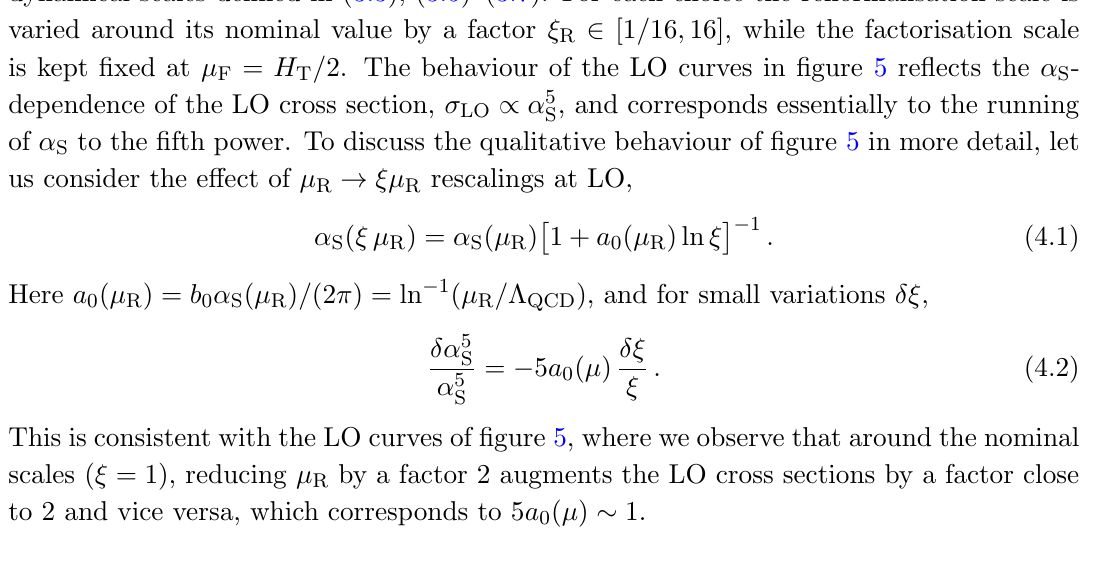
Figure 5. Renormalisation-scale dependence of the LO (dashed) and NLO (dotted) cross sections at p s = 13 TeV in the ttbbj phase space. The di(cid:11)erent curves correspond to the four dynamic scales de(cid:12)ned in (3.3), (3.5){(3.7). More precisely, instead of (cid:22) T ; tot = H T = 5, the scale H T /4 is shown in this plot. Each scale is varied around its nominal value ( (cid:24) R = 1) by a factor (cid:24) R and the factorisation scale is kept (cid:12)xed at (cid:22) F = H T = 2. Absolute predictions are shown in the main frame, while the ratio plot shows the NLO correction factor K ( (cid:24) R ) = (cid:27) NLO ( (cid:24) R ) =(cid:27) LO ( (cid:24) R ). scale variations is illustrated through two bands, which correspond to the variation of (cid:22) R alone and the full 7-point variation of (cid:22) R and (cid:22) F . The results demonstrate that (cid:22) F